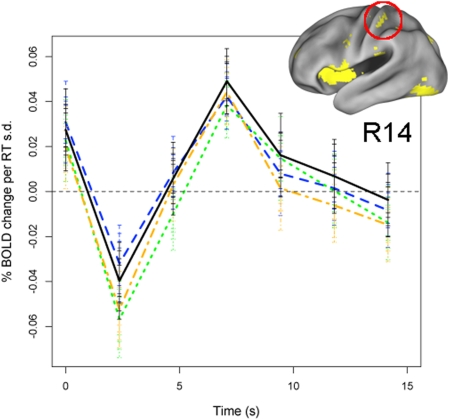
RT-related activation in somatosensory cortex estimated separately by trial type in Sample 2.Each colored line represents the time course of RT-related activation estimated for a different trial type, after controlling for a range of experimental covariates (see text). The black line represents the original estimate (cf. Figure 4A) when collapsing across all trial types. Error bars indicate 95% C.I.